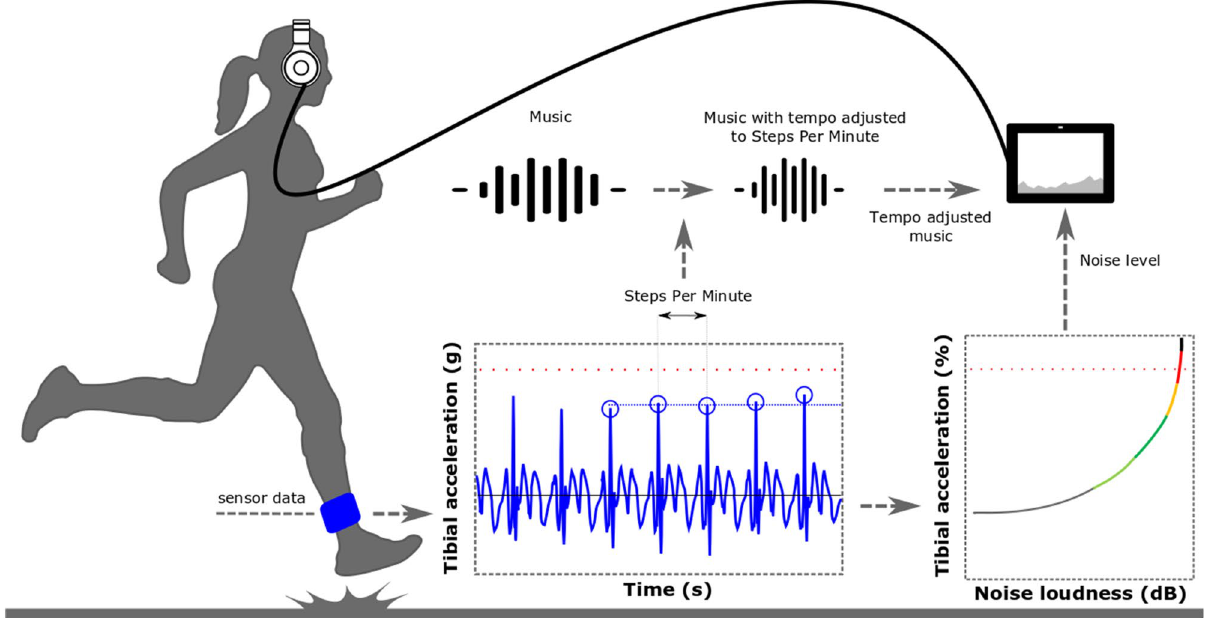
Figure 2. Schematic representation of the biofeedback system’s main components for continuous biofeedback on tibial shock (axial peak tibial acceleration). An interaction loop of the smart music player that provided the auditory biofeedback in real-time and that continuously accounted for (in)voluntary alterations in the running cadence by aligning the tempo (beats per minute) of the music to the cadence (steps per minute) of the runner. The red horizontal line indicates the baseline tibial shock. The five most recent values of tibial shock are averaged and mapped to a discretized level of noise loudness, which is added to the music